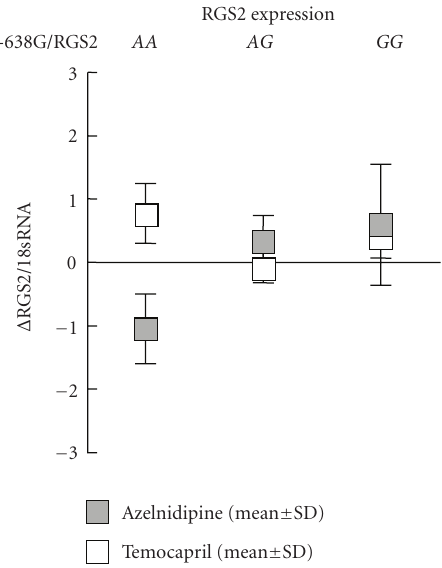
Figure 4: Relationship between A-638G polymorphism of RGS2 gene and RGS2 gene expression in peripheral